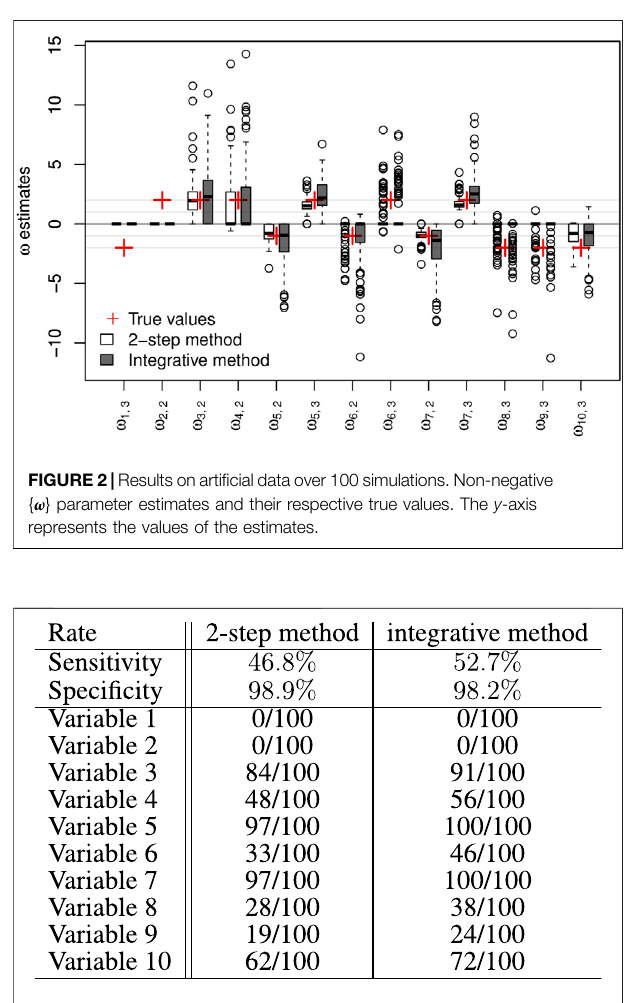
FIGURE 3 | Global sensitivity and speci fi city of the integrative method compared with the 2-step method for the selection of the genetic variables in the arti fi cial data experiment with 100 simulations. Among 2,657 variables, 10 had to be selected. The number of times these variables have been selected over the 100 simulations is also speci fi ed for both